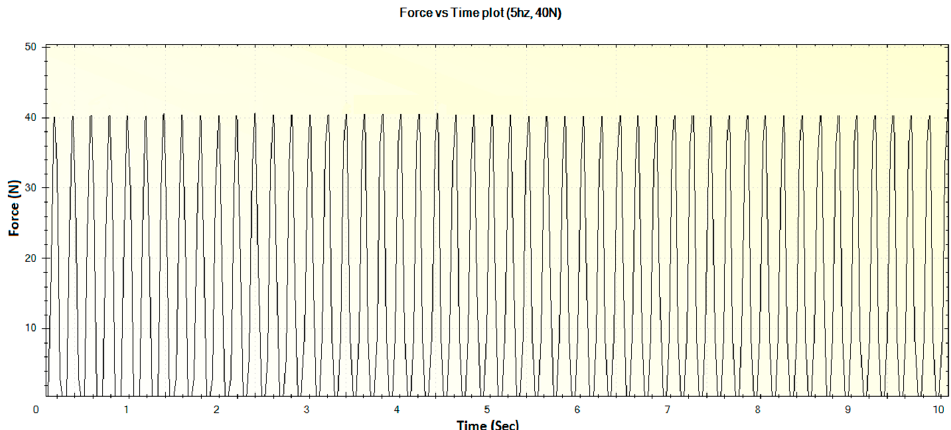
Figure 23. Generated waveform for 5 Hz operation producing a force of 40 N.